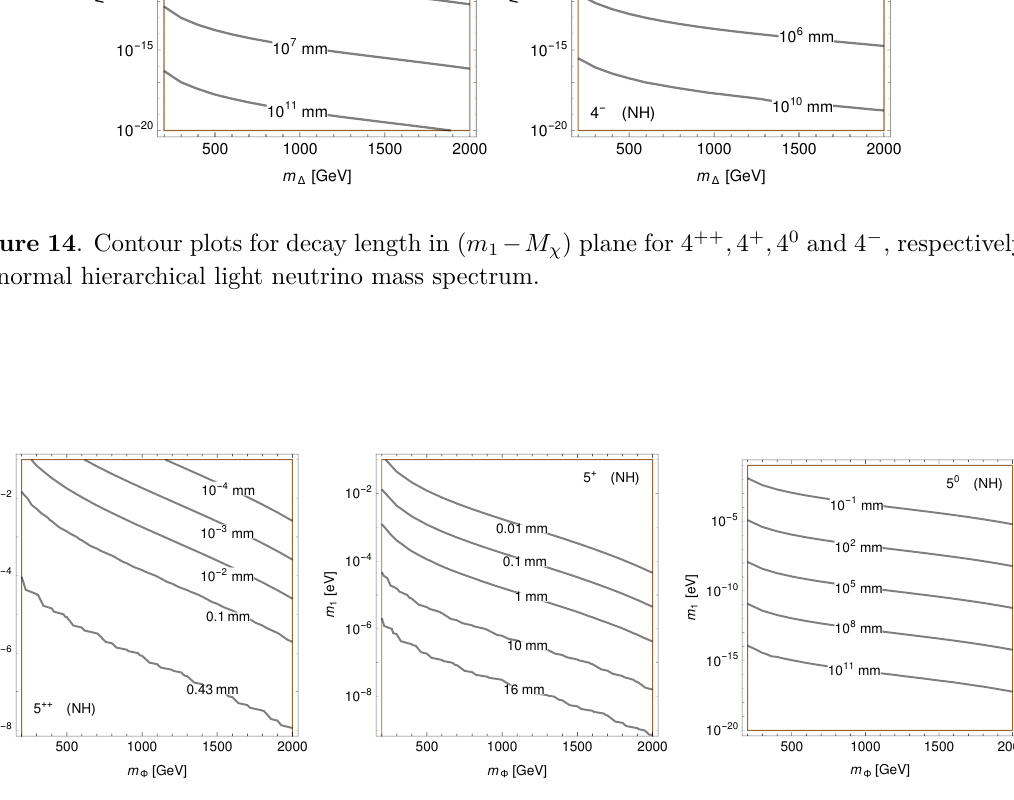
Figure 15 . Contour plots for decay lengths in ( m 1 − m ∆ ) plane for 5 ++ , 5 + and 5 0 for normal hierarchical light neutrino mass